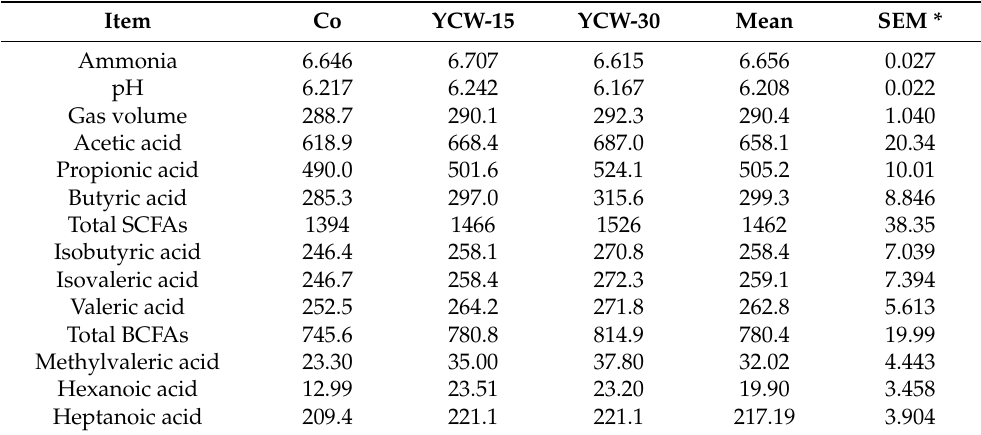
Table 7. Fermentation products (mmol), gas volume (mL), and in vitro pH corrected for fecal dry matter using fecal inoculum from cats fed control diet in Exp.